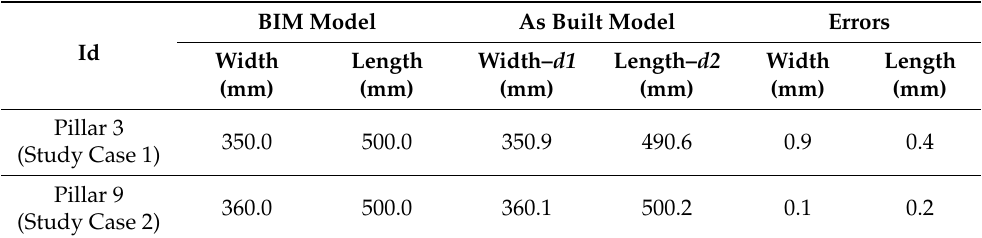
Figure 11. ( a ) Point cloud of a pillar obtained after the automatic registration proposed; ( b ) plane adjustment for each pillar face; ( c ) control measurements performed on the pillar. Table 7. Result of the control measurements performed on pillar 3 (study case 1) and on the pillar 9 (study case 2). The measurements performed correspond to distances between opposite sides of the pillar (Figure